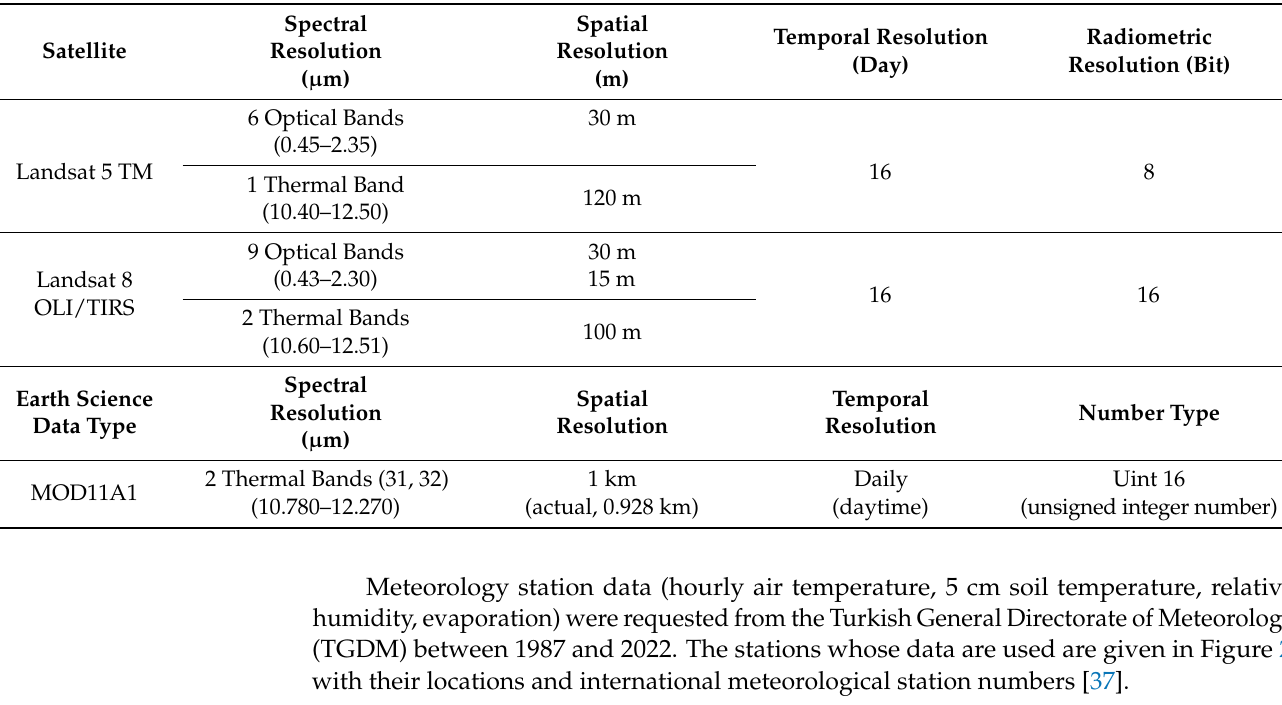
Table 1. Characteristics of Landsat 5 TM, Landsat 8 OLI/TIRS, and Terra MODIS MOD11A1.